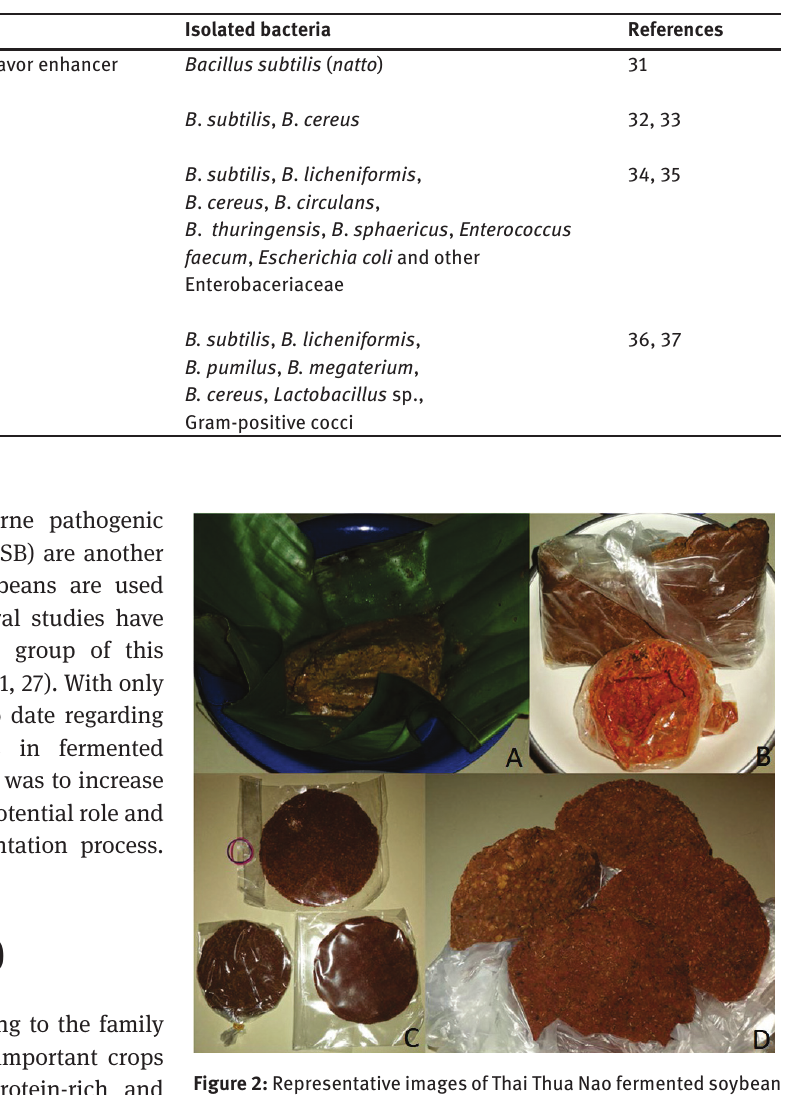
Figure 2: Representative images of Thai Thua Nao fermented soybean (FSB) products. (A - B) Fresh Thua Nao products. (C - D) Dried Thua Nao products.